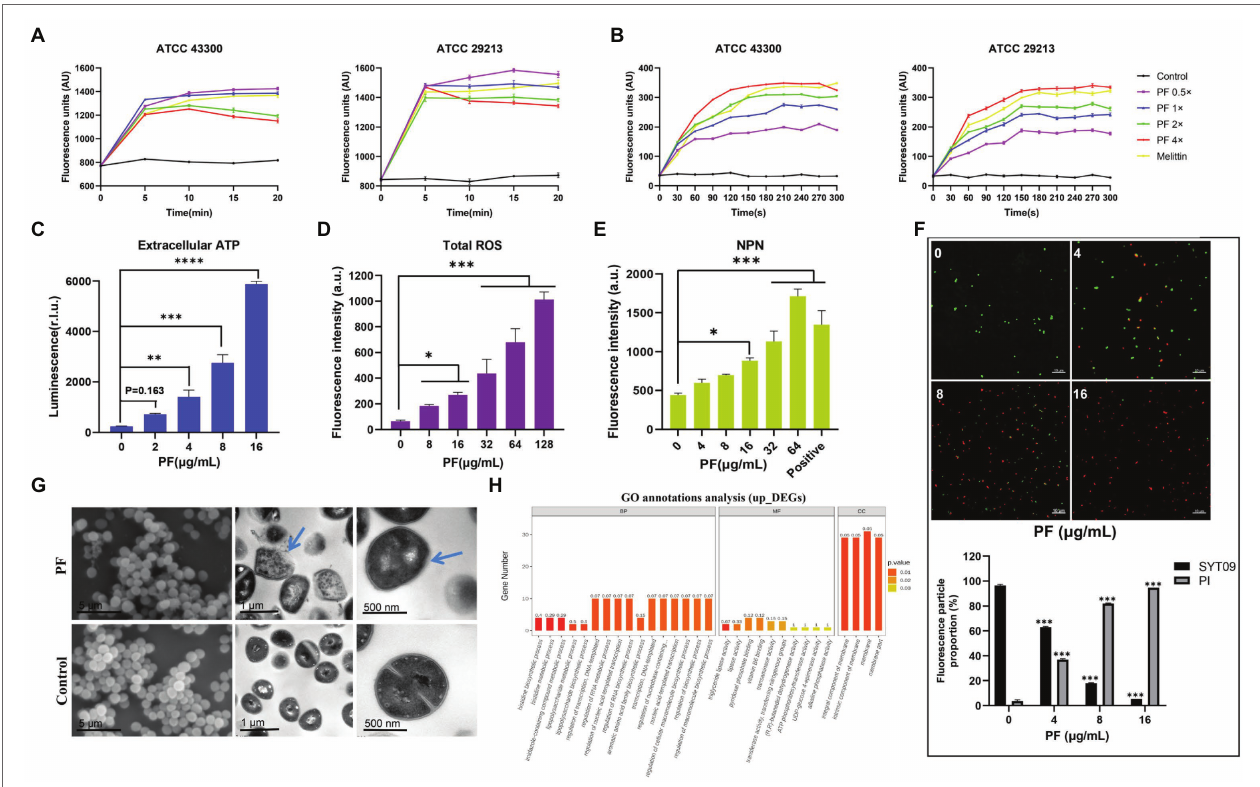
FIGURE 4 | Mechanism of the antibacterial effect of PF against S. aureus . Staphylococcus aureus ATCC 29213 and ATCC 43300 were treated with various concentrations of PF, and the fluorescence intensity of (A) SYTOX Green and (B) Disc3(5) was measured by a microplate reader. (C) Increased levels of extracellular ATP in S. aureus ATCC 43300 after the treatment with PF. (D) Total ROS accumulation after treatment with PF. (E) Detection of membrane permeability with N-phenylnaphthylamine (NPN) probe. (F) Confocal images of S. aureus ATCC 43300 exposed to PF (0–16 μ g/ml) for 1 h; live bacteria were stained green by SYTO9, whereas dead bacteria were stained red by PI. (G) Scanning electron and transmission electron microscopy (TEM) images of S. aureus ATCC 43300 treated with 64 μ g/ml PF. Blue arrows represent areas with significant morphological changes. Scale bars, 5 μ m (left), 1 μ m (middle), and 100 nm (right). (H) GO annotation analysis of upregulated differentially expressed genes (DEGs) in S. aureus ATCC 43300 after exposure to PF for 1 h. * p < 0.05; ** p < 0.01; *** p < 0.001; **** p <